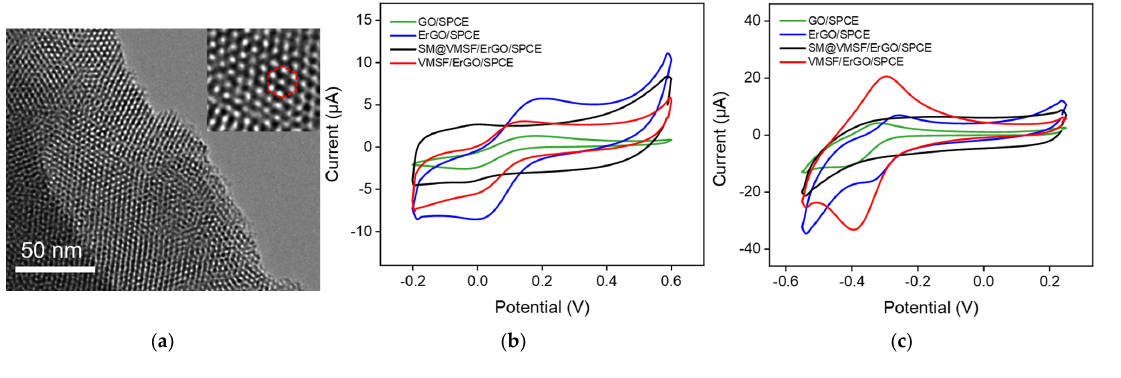
Figure 3. ( a ) Top − view TEM images of VMSF at different magnifications; CV curves of different electrodes (GO/SPCE, ErGO/SPCE, SM@VMSF/ErGO/SPCE, VMSF/ErGO/SPCE) in 50 mM potassium phthalate (KHP) solution containing 0.5 mM ( b ) K 3 [Fe(CN) 6 ] and ( c ) Ru(NH 3 ) 6 Cl 3 at a scan rate of 50